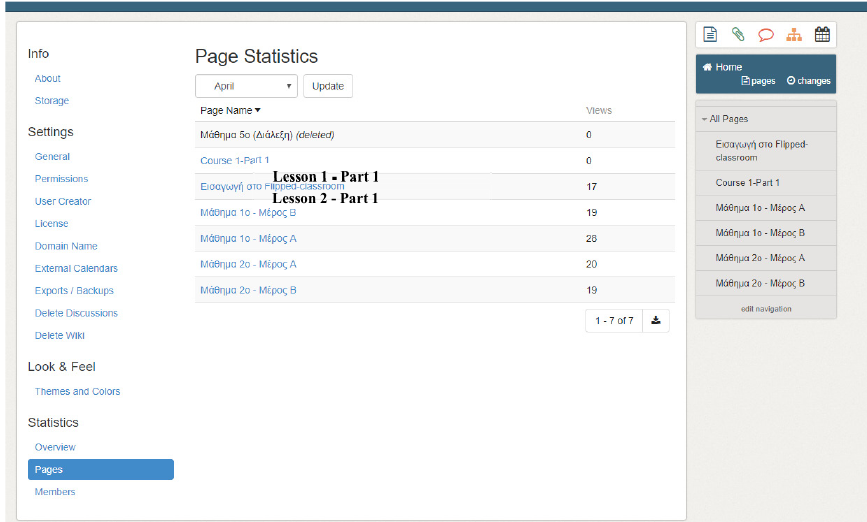
Fig. 3. The wiki provides 'Page Statistics' data referring to number of views on each page.